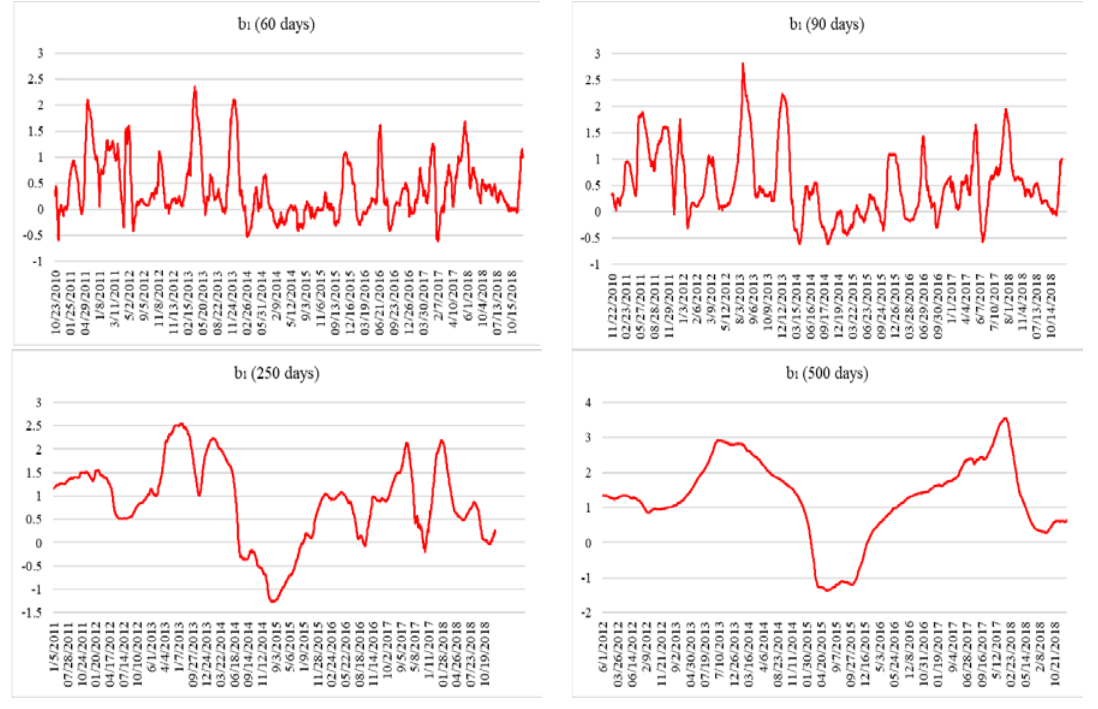
Figure 7 : The b 1 coefficient for Metcalfe’s law (Equation 6), estimated on rolling windows of 60, 90, 250 and 500 trading